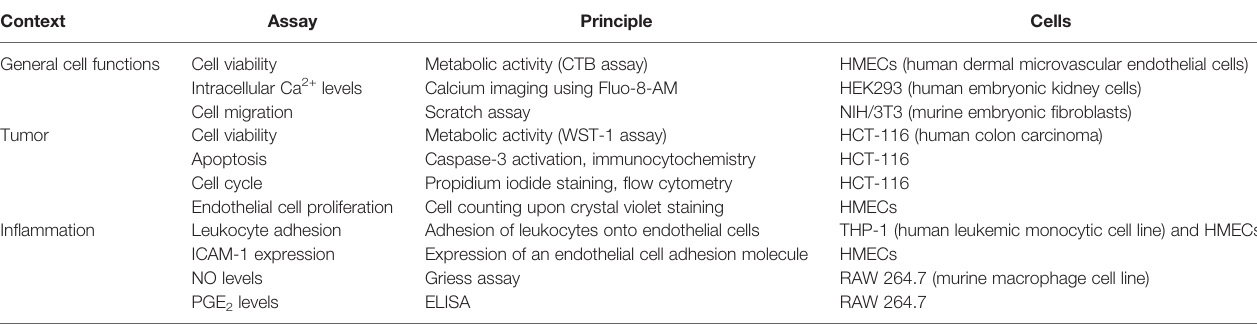
TABLE 1 | Summary of the functional and biochemical test systems.